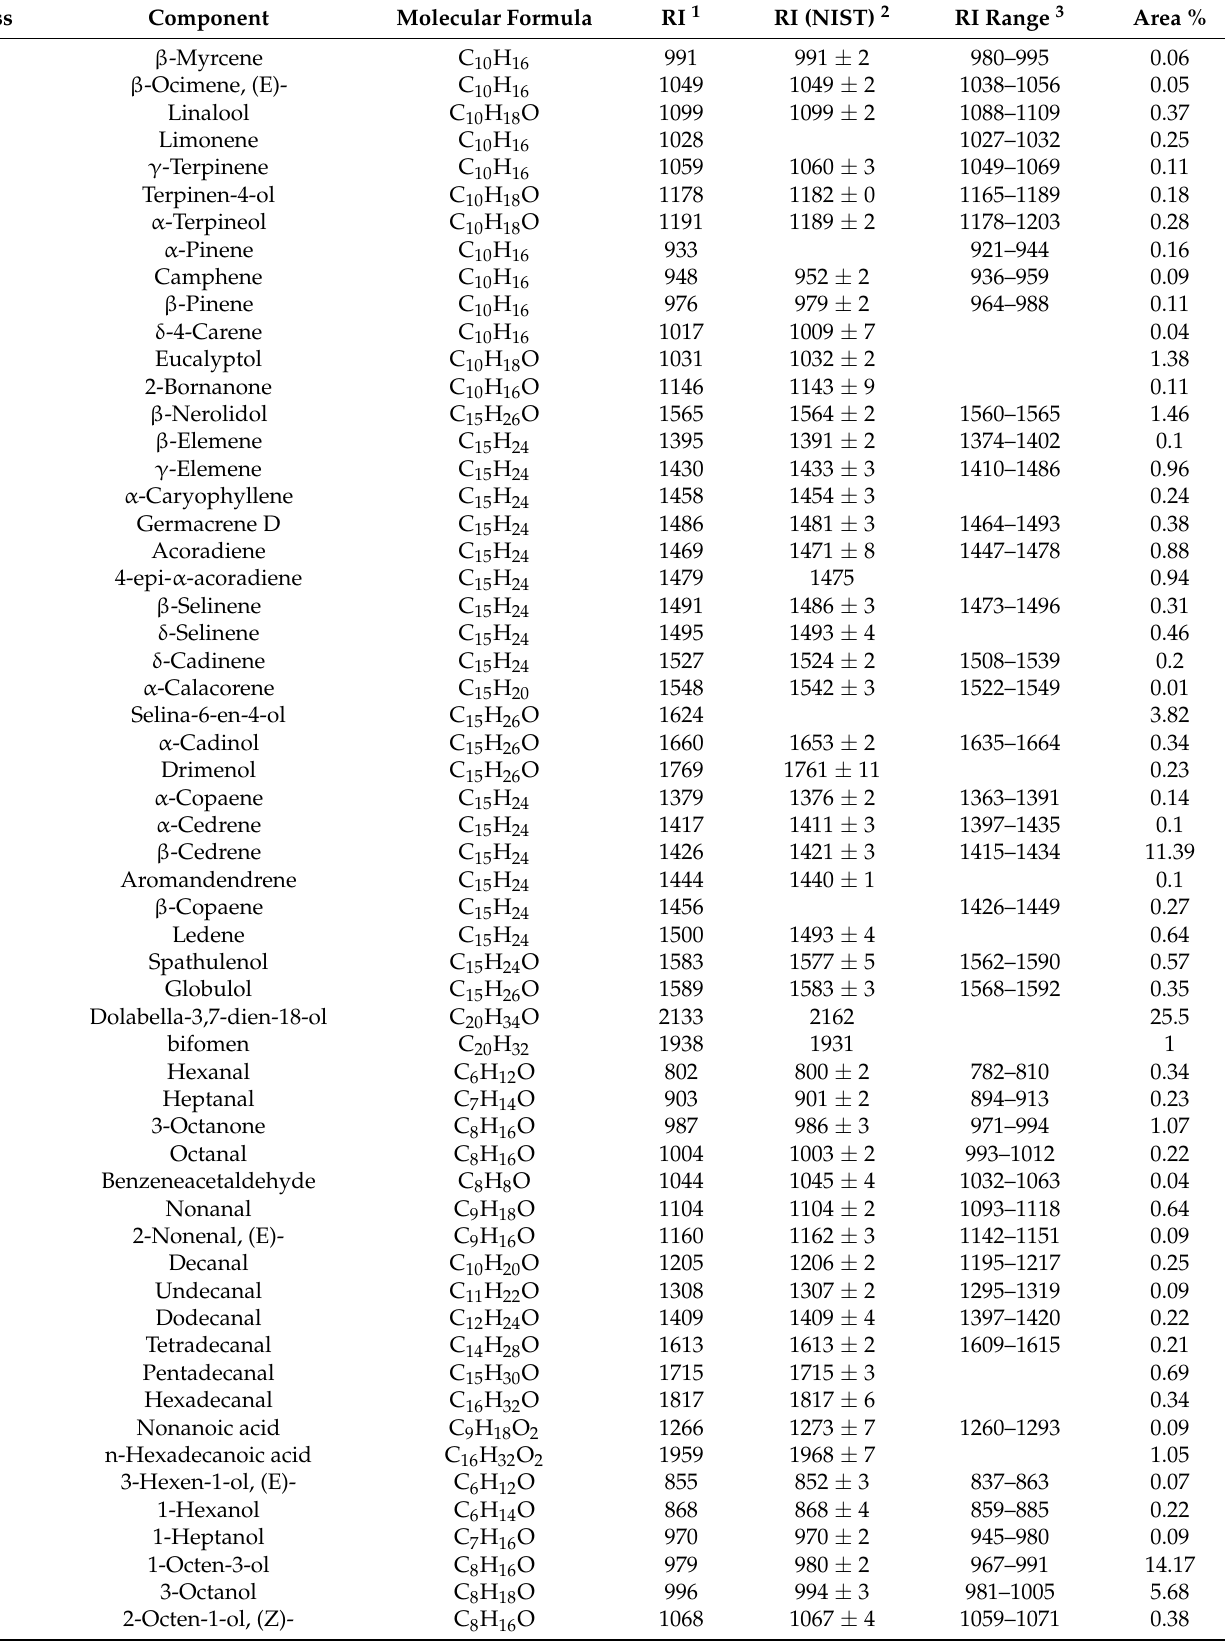
Table 1. Composition and content of